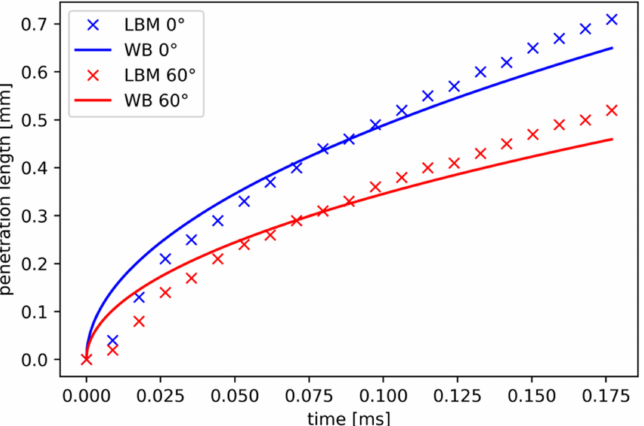
Figure 4. Comparison of the time-dependent penetration length for LBM and analytical Washburn (WB) equation at CA 0 ◦ and 60 ◦ .